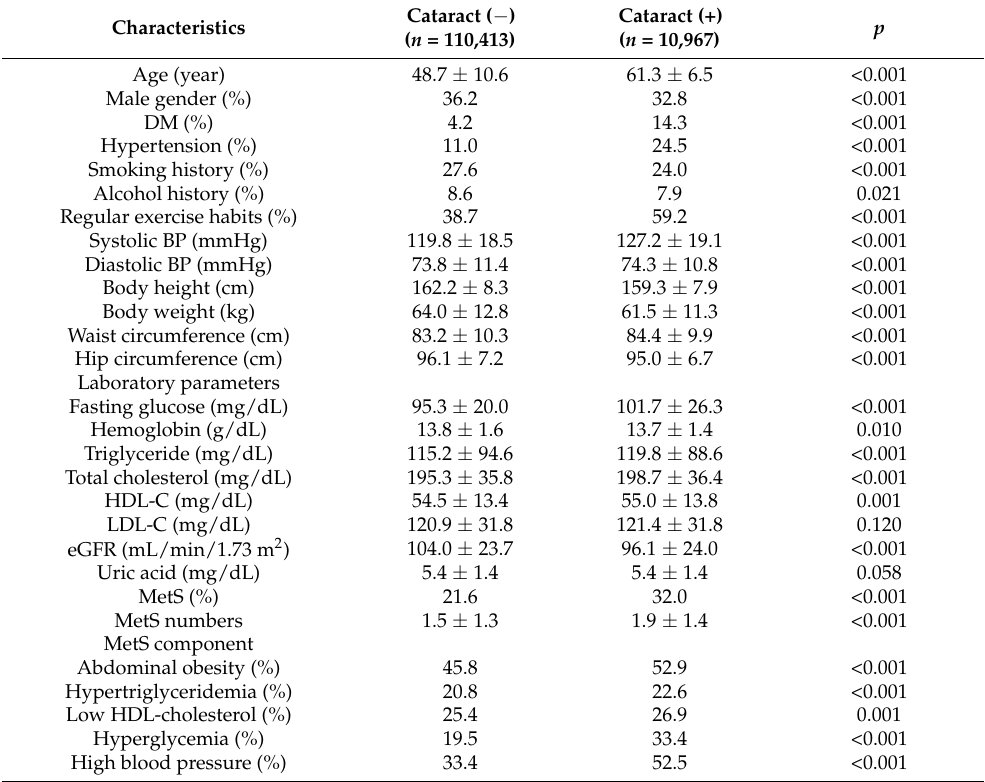
Table 1. Comparison of clinical characteristics among study participants according to cataract. Characteristics